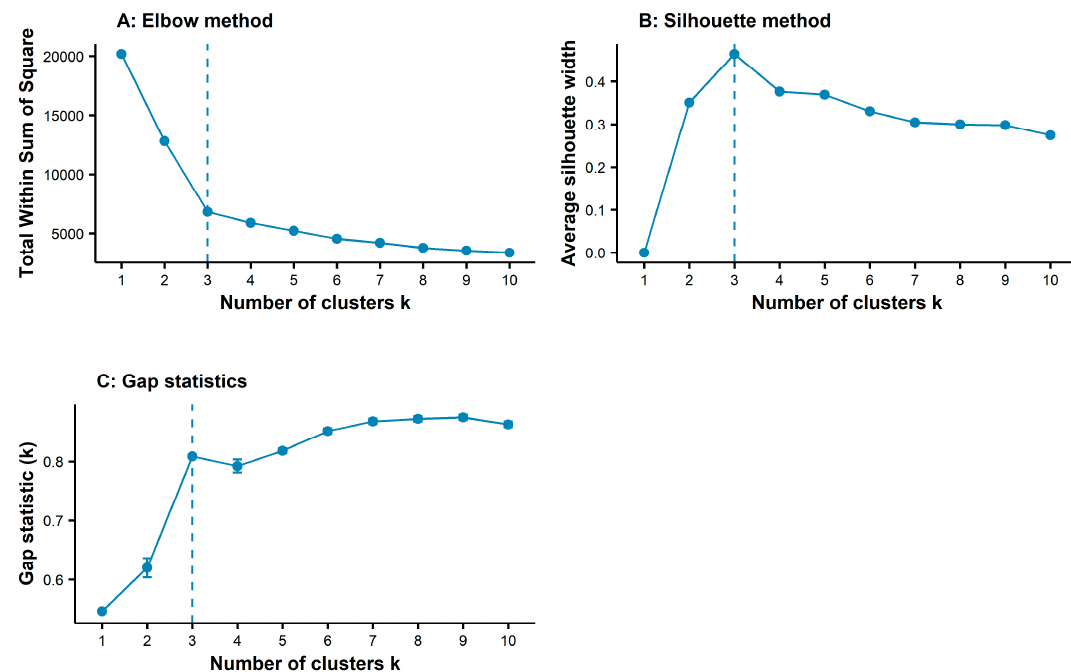
Figure 3. Optimal number of clusters is 3 indicated by ( A ) elbow method (left), ( B ) k-average silhouette width (right), and ( C ) gap-statistics (lower) methods. The figure shows the 2013–14 data, where the three methods suggested consistent optimal k indicated by the dotted vertical lines. Table 3. Silhouettewidth(si)andisolationindexfortheCLARA(ClusteringLargeApplications)clustering. Average Shallow Waters Wet Meadows Rushes Year Si Isolation Si Isolation Si Isolation Si